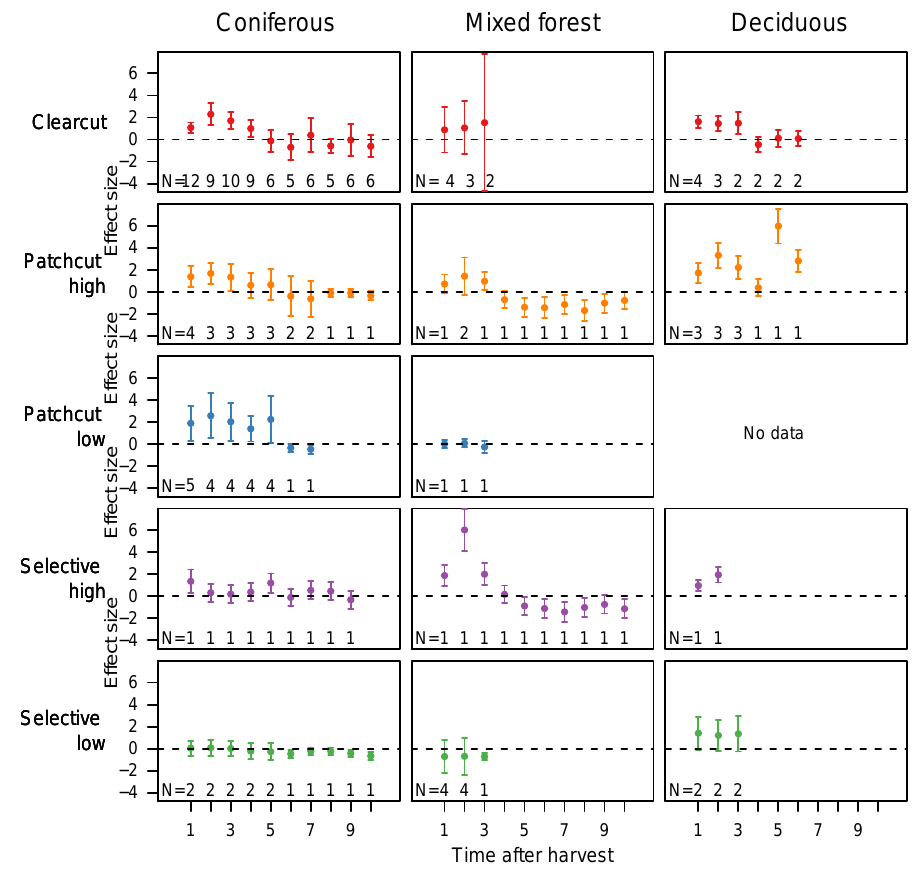
Figure 2. Subgroup analysis for every combination of forest harvest and forest composition. Summary effect sizes are plotted with confidence intervals against time for the first ten years. Number of studies entering the subgroup analysis is given by “N =” in each plot. Coniferous and deciduous forests show a significantly elevated nitrate concentration three to five years after clearcut and patchcut harvests, contrary to mixed forests. Selective harvest at low intensity does not significantly influence nitrate